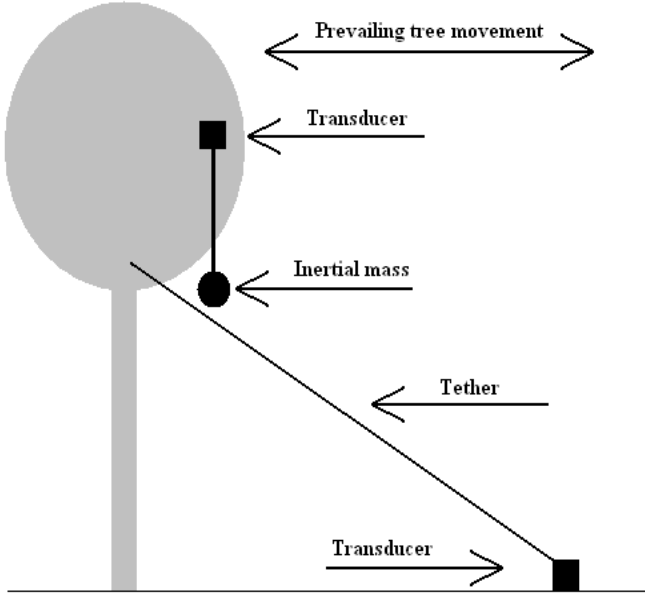
Figure 1. ‘Tethered’ and ‘Inertial Mass’ general